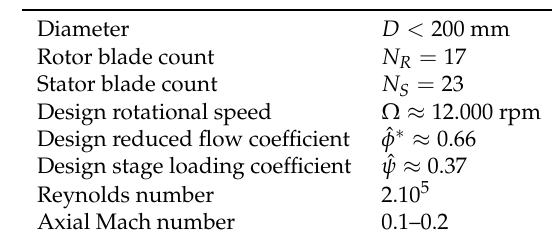
Table 1. Fan stage characteristics, from the authors of [5].